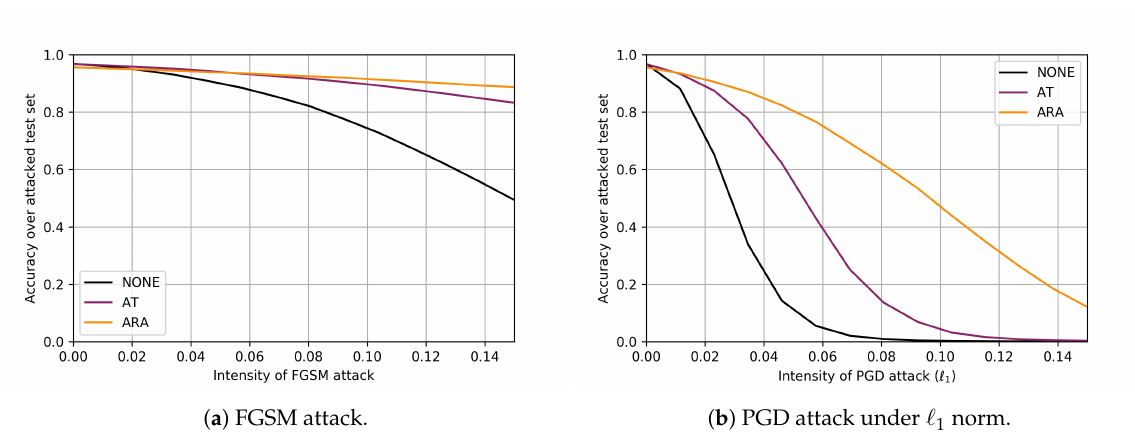
Figure 6. Robustness of a deep network for MNIST under three defence mechanisms (none, AT, ARA). ( a ) depicts the security evaluation curves under the FGSM attack. ( b ) depicts the security evaluation curves under the PGD